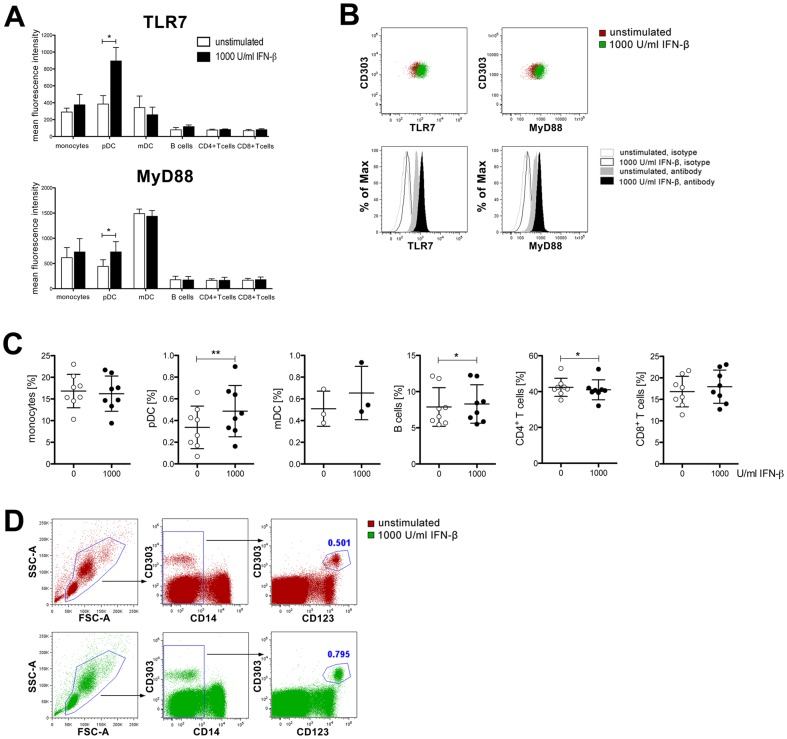
Interferon-β upregulates TLR7 and MyD88 protein expression in plasmacytoid dendritic cells in vitro.(A, B, C, D) PBMCs were either incubated with 1000 U/ml interferon-β or left untreated. (A) After 24 hours cells were stained with antibodies to TLR7 and MyD88 as well as isotype controls and analyzed by flow cytometry. Mean fluorescence intensity (MFI) was determined. Results are presented as mean±SD (MFITLR7 or MyD88 – MFIisotype) from n = 3 healthy donors for each cell type and TLR. (B) Representative dot plots and histogram plots of TLR7 and MyD88 expression in pDCs. (C) Percentages of each cell population of all live cells are depicted with each dot representing one healthy donor. (D) Representative dot plots display the gating strategy for pDCs. Statistical significance was assessed by paired t-test. IFN-β, interferon-β; *p<0.05; **p<0.01.